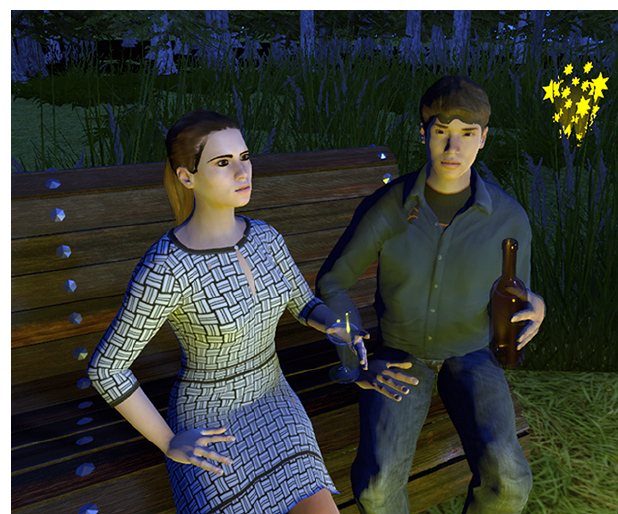
Figure 18. Humanoid puppets which fall into the ‘Characters’